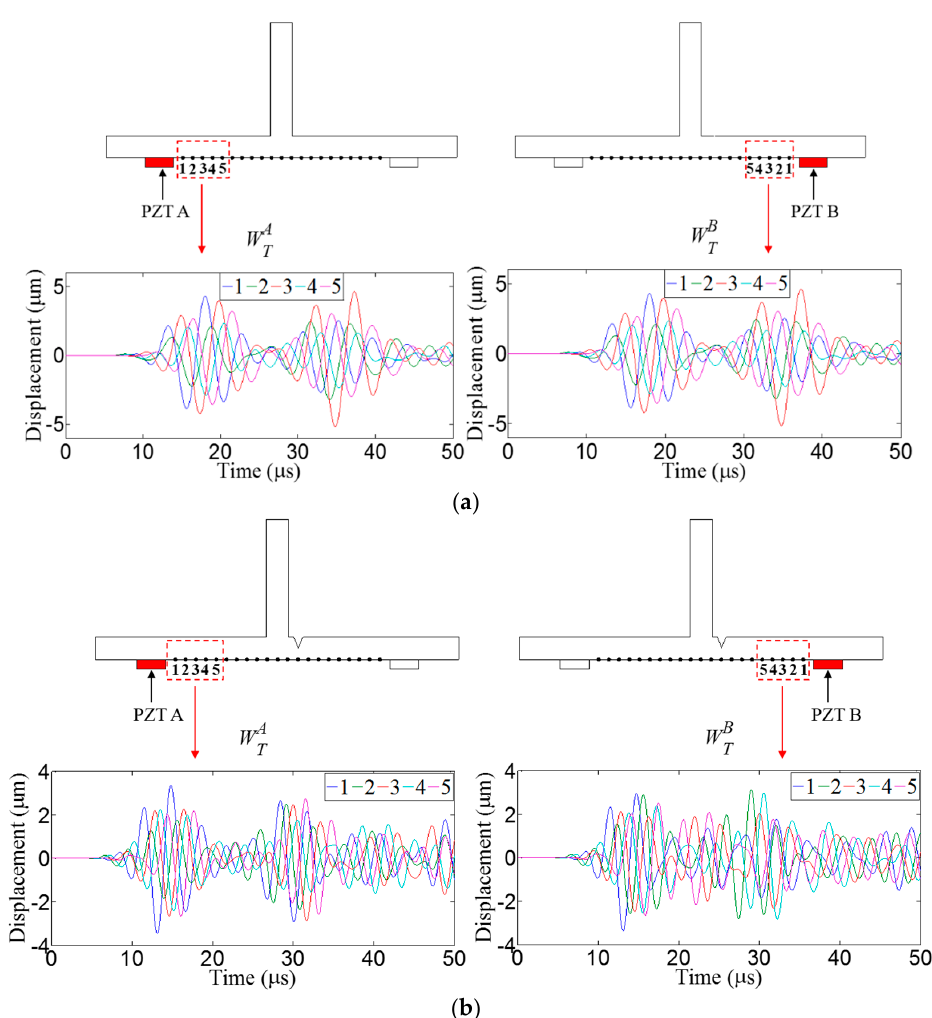
Figure 5. Representative (cid:1849) (cid:3021)(cid:3002) and (cid:1849) (cid:3021)(cid:3003) obtained from ( a ) intact and ( b ) crack models when the driving frequency is 150 kHz. frequency is 150